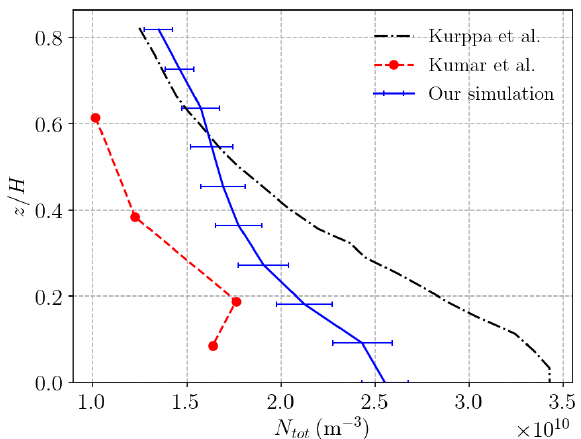
Figure 5. Vertical profiles of the aerosol number concentration within a street canyon in Cambridge, UK. The original in situ evening measurements (Kumar et al., 2008) are plotted in red. LES simulations using PALM–SALSA from K19 and the current study are plotted in black and blue, respectively. Error bars (standard de- viations) for the current LES are plotted with horizontal lines. Table 3. As in Table 2 but for deep-frying and boiling emissions from isolated kitchens. NOAD AD